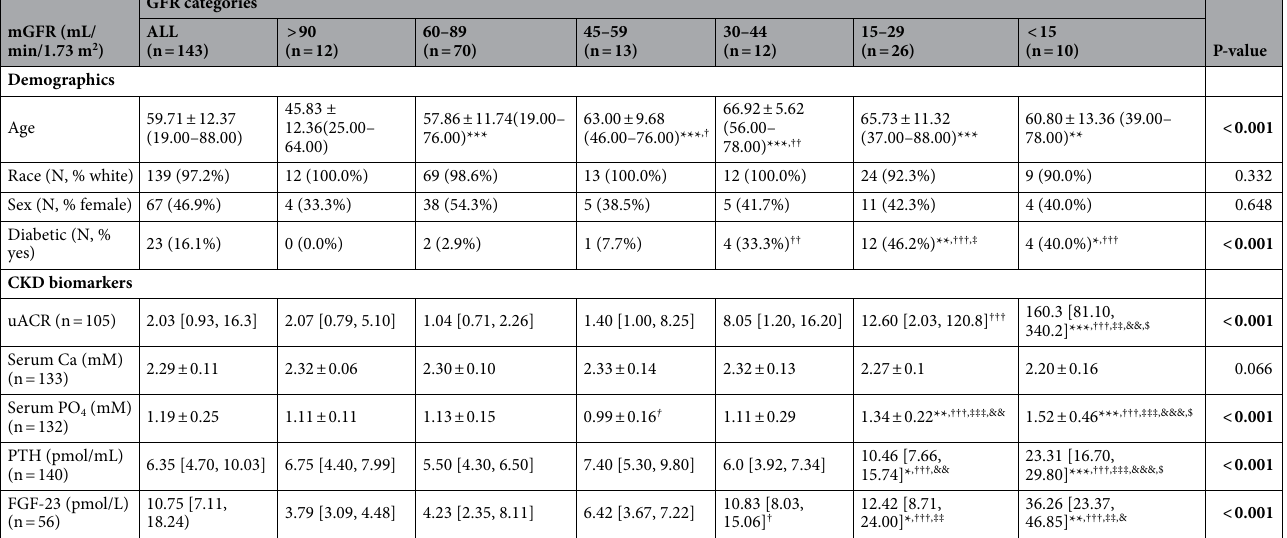
Table 1. Demographics of participants stratified by measured GFR. Data represented by mean ± SD for normally distributed measures or median [IQR] for non-normally distributed. P-value indicates significance of one-way ANOVA or non-parametric equivalent. Differences between groups evaluated using Fisher LSD test if global test has p < 0.05. uACR urinary albumin-to-creatinine ratio, PTH parathyroid hormone, FGF-23 fibroblast growth factor 23. *p < 0.05, **p < 0.01, ***p < 0.001 indicates significance compared to > 90, † 60–89. ‡ 45–59, & 30–44, $ < 15. Significant values are given in